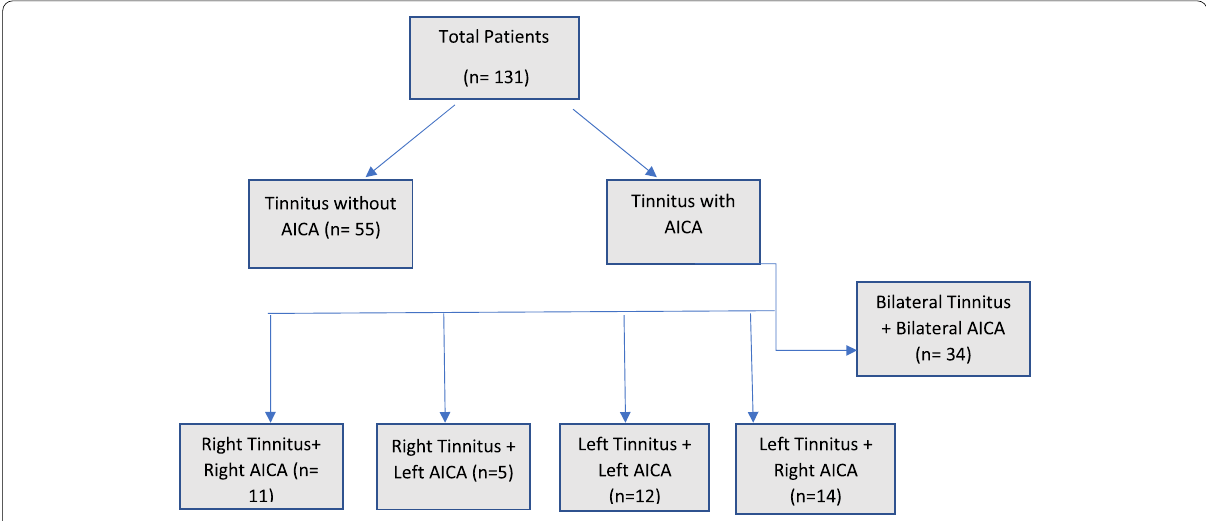
Fig. 3 Flow diagram showing distribution of tinnitus and